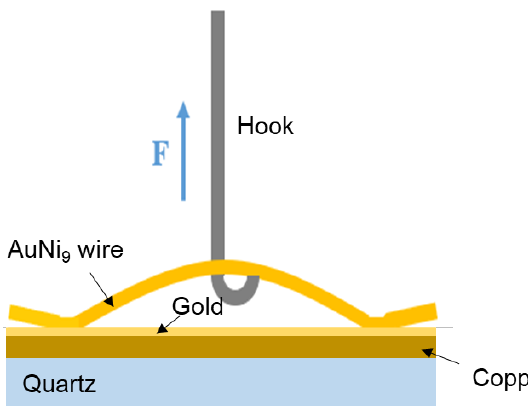
Figure 4. Schematic diagram of measuring the tensile force.